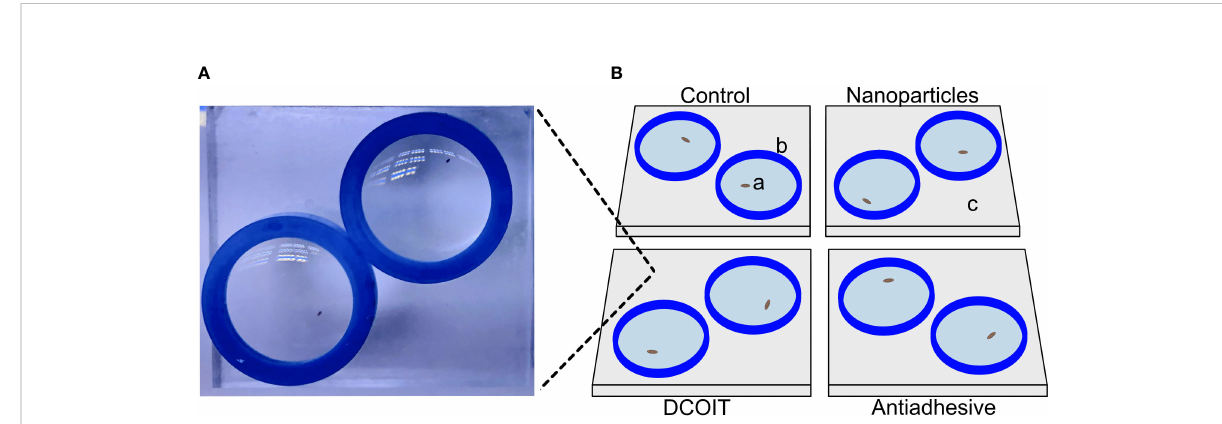
FIGURE 1 Tile setup beneath one camera. Actual image (A) of one tile setup (here: DCOIT tile). Schematic diagram (B) with coral larvae (a), silicone sealing ring (b), PMMA tile